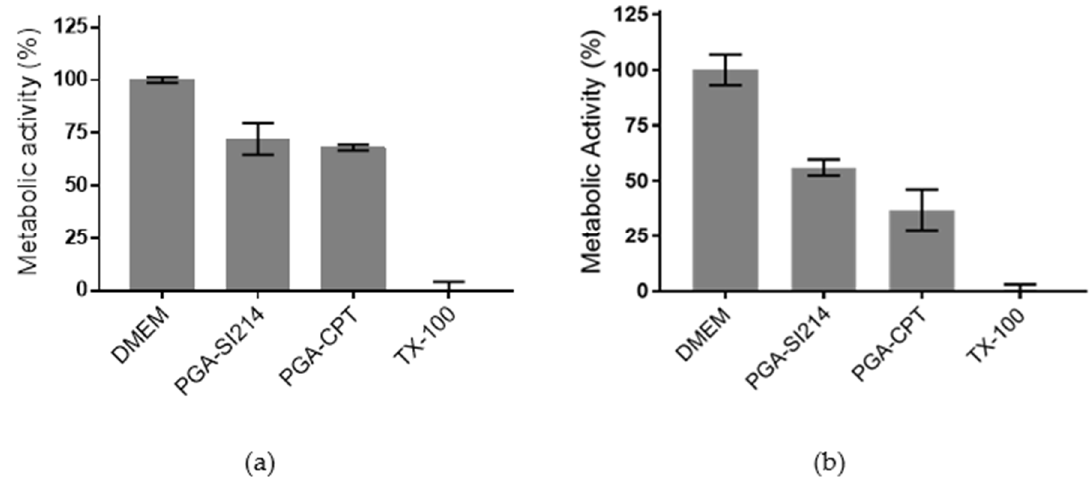
Figure 3. In vitro cytotoxicity of study formulations on Caco-2 ( a ) and HCT116 ( b ) intestinal epithelial cells. Formulations were applied to cells at a polymer concentration of 0.5 mg/mL diluted in Dulbecco's Modified Eagle Medium (DMEM) containing 10% Fetal Bovine Serum (FBS) for 48 h. A total of 1% (v/v) Triton X-100 (TX-100) was used as the positive cell death control. Caco-2 and HCT116 cells were seeded on 96 well plates at a density of 1 × 10 4 and 2 × 10 4 cells/well, respectively, and were cultured for 24 h prior to assaying. Metabolic activity was assessed using the PrestoBlue assay. The data represent mean ± S.D. (n = 3).